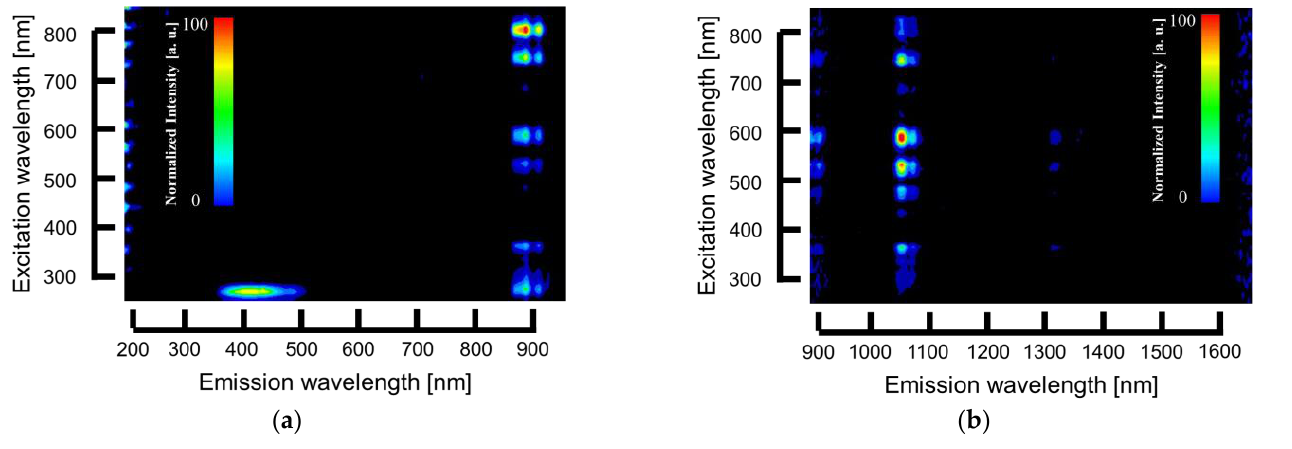
Figure 4. PL excitation and emission contour maps of 1% Nd-doped CaWO 4 monitored ( a ) 195 – 950 nm and ( b ) 895 – 1675 nm.